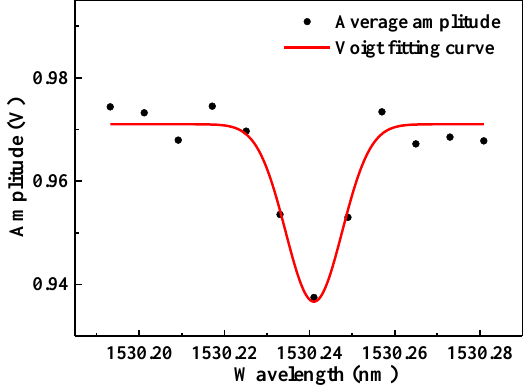
Figure 9. Ten averaged H 2 O absorption spectra at a concentration level of 1.6%, a pressure of 0.92 atm and a temperature of 296 K.